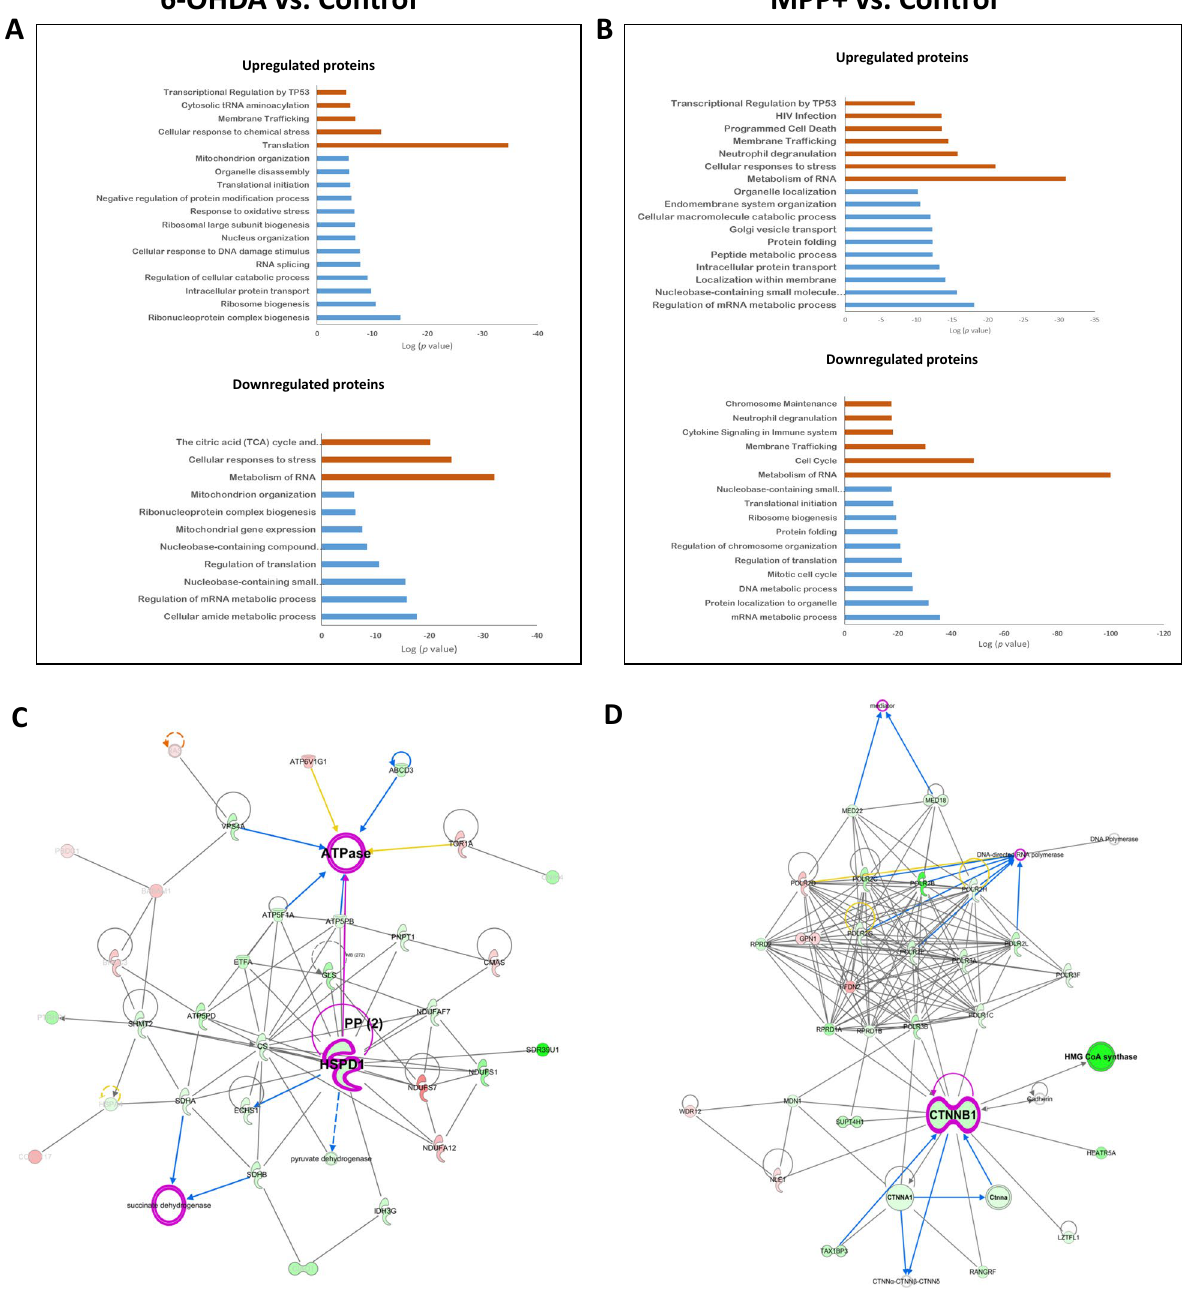
Fig. 3 Comparative analysis of the proteome of neurodegeneration induced by 6‑OHDA or MPP in SH‑SY5Y cells. The GO classification terms of + biological process (blue bar), and reactome gene set analysis (orange bar) using Metascape online database on differentially expressed proteins ( p < 0.05) in A 6‑OHDA‑treated SH‑SY5Y cells compared with untreated SH‑SY5Y cells and B MPP ‑treated SH‑SY5Y cells compared with untreated + SH‑SY5Y cells. Ingenuity pathway analysis of differentially expressed proteins ( p < 0.05) after C 6‑OHDA and D MPP treatment. Proteins are colored + red (up) or green (down) based on fold‑change values. (For interpretation of the references to color in this figure legend, the reader is referred to the Web version of this article). 6-OHDA 6‑hydroxydopamine, MPP +